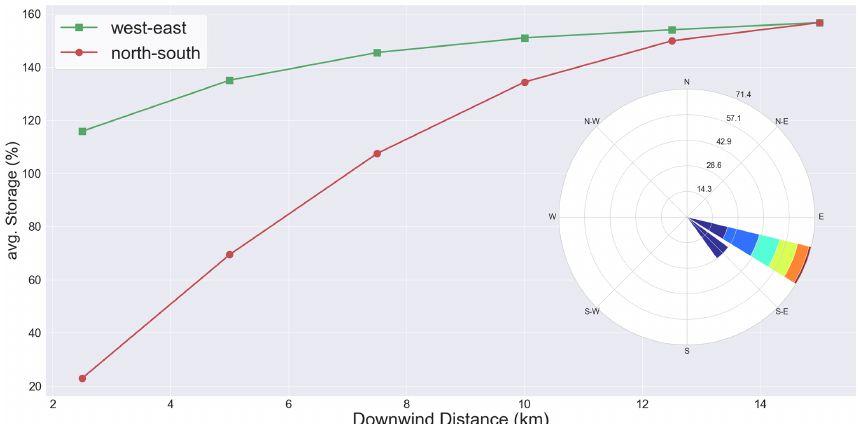
Figure C1. The contribution of the storage rate term ( E C , S ) to the net retrieved emission rates ( E C ) as a function of downwind distance for case 8. As shown in the wind-rose diagram, the wind direction for this case was towards south–east (S–E), and therefore the downwind dependence is shown in two directions west–east (green squares) and north–south (red circles). The contribution of storage increases as a function of downwind distance. This suggests that the impact of storage release may increase as the distance between the downwind screen (sampling location) and the emission sources increase. A similar dependence of the magnitude of the storage release with downwind distance was observed for the other